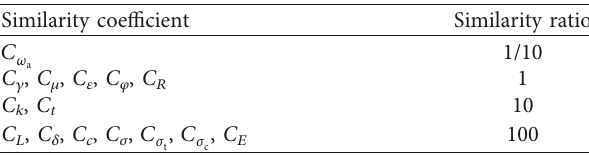
Table 2: Similarity